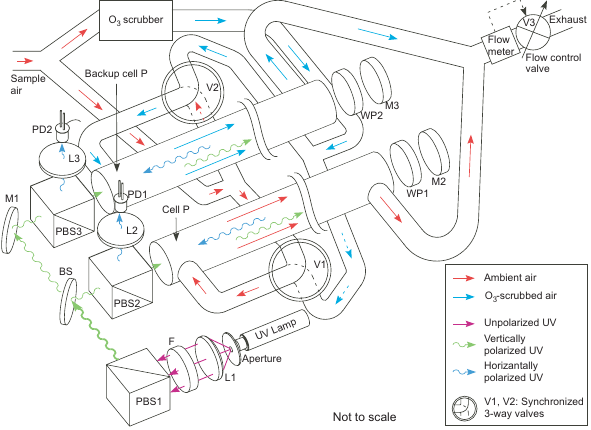
Fig. 1. Schematic of the new NOAA-2 O 3 instrument showing the configuration of the key optical and air flow components: Ln: lens; F: UV filter; PBSn: polarizing beam splitter; BS: polka-dot 50-50 beam splitter; Mn: mirror; WPn: quarter-wave plate; PDn: silicon photodiode detector; V1 and V2: synchronized 3-way flow-control valves; V3: flow-control valve. Schematic is not to scale. The legend indicates how the polarizations of the UV beams, and scrubbed and unscrubbed sample air are